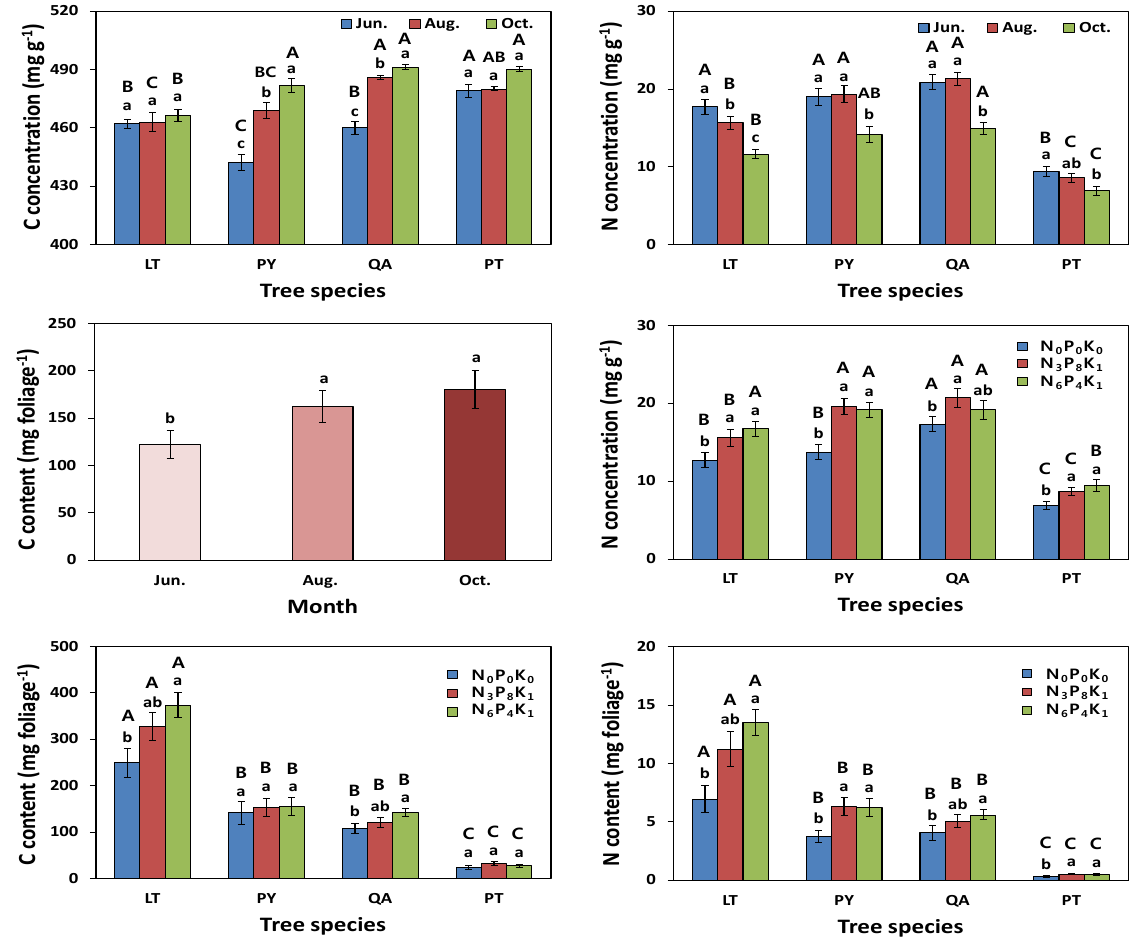
Figure 5. Carbon and nitrogen concentration and content of foliage by tree species and sampling month in a fire-disturbed urban forest (mean ± standard error). Treatment means with the same lower case letter among sampling month or fertilizer treatments and treatment means with the same upper case letter among tree species are not significantly different at p < 0.05. LT: Liriodendron tulipifera L.; PY: Prunus yedoensis Matsumura; QA: Quercus acutissima Carruth; and PT: Pinus thunbergii Parl. A significant two-factor interaction between the tree species and fertilizer treatments on the C/N ratio of foliage was observed (Figure 6). The C/N ratio in all tree species was significantly lower in the fertilizer than in the N 0 P 0 K 0 treatments, regardless of the compound ratio of fertilizer, while the C/N ratio was significantly higher in conifers (PT) than in broadleaf tree species (LT, PY, and QA). The C/N ratio was also highest in October, followed by August and June (Figure